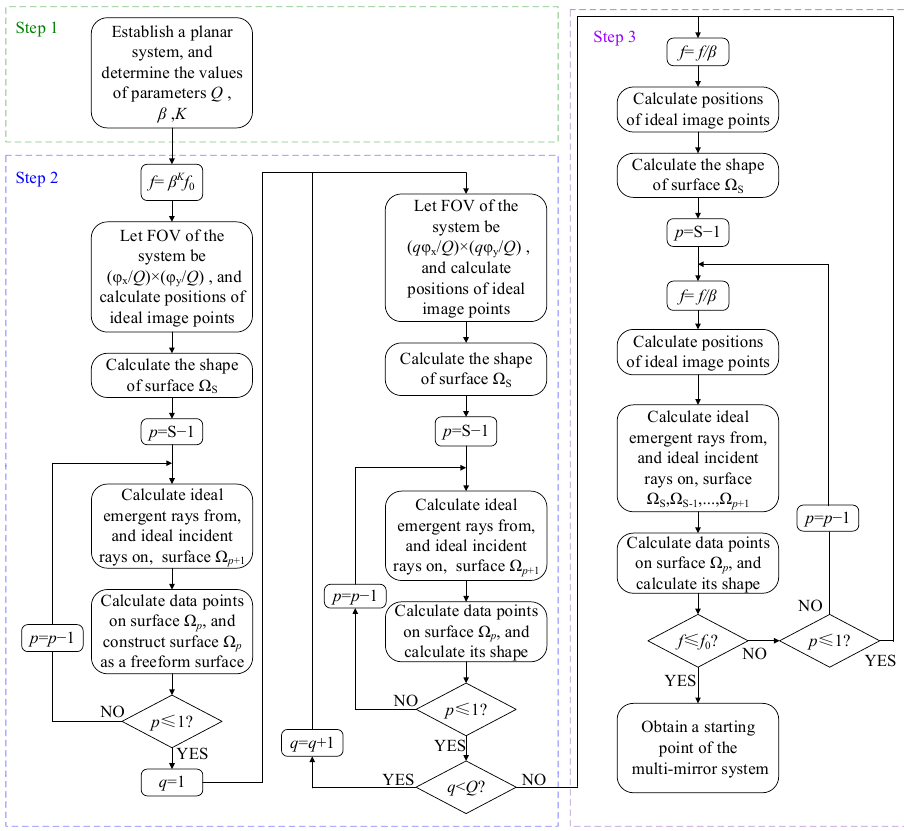
Figure 3. Flowchart of the design process.